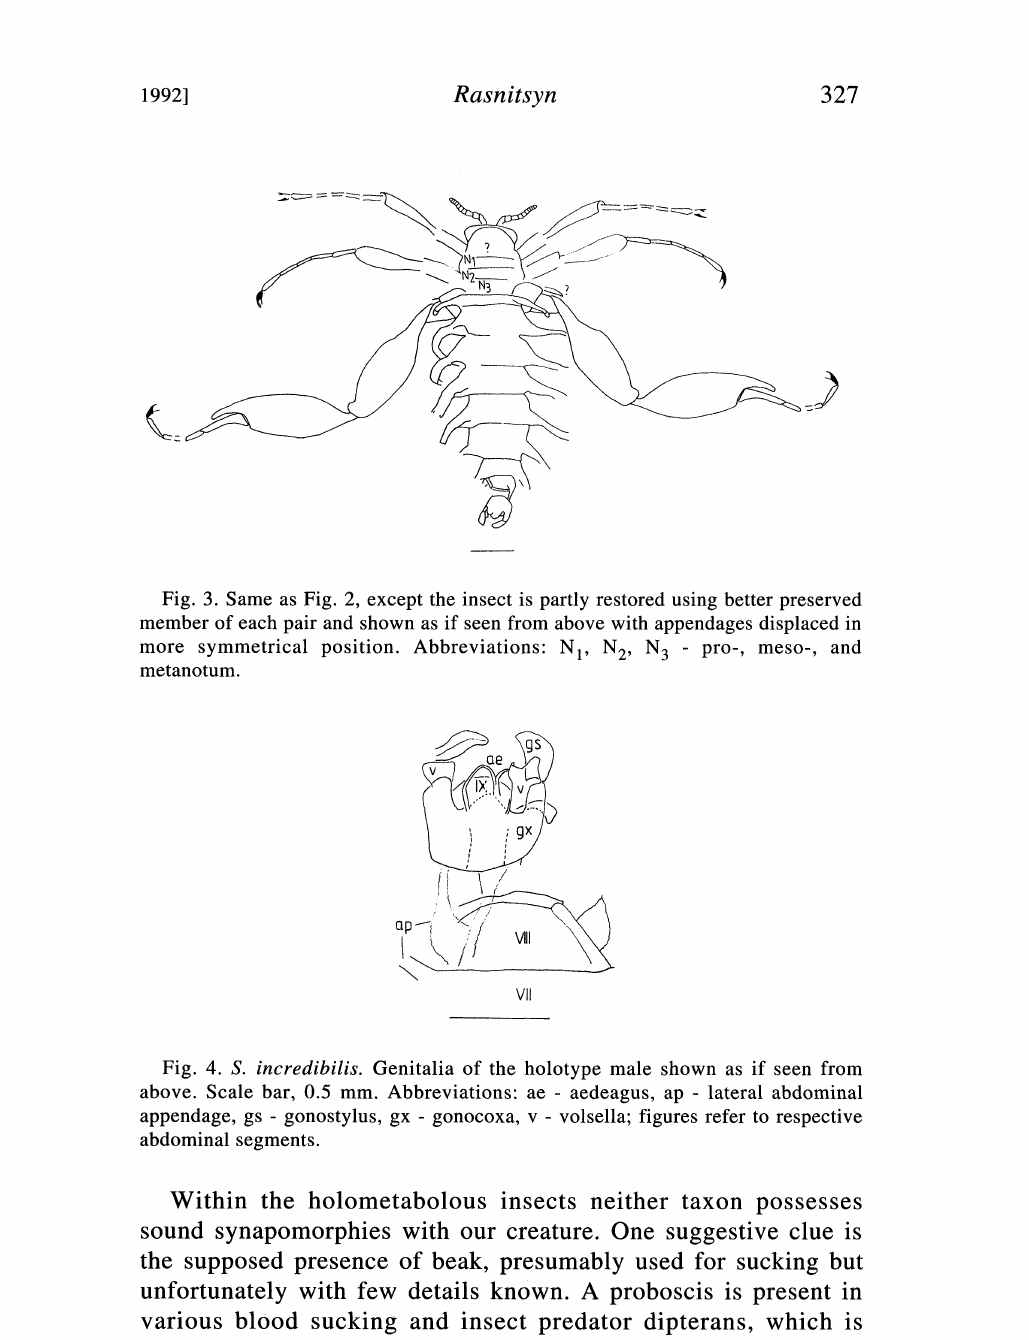
Fig. 4. S. incredibilis. Genitalia of the holotype male shown as if seen from above. Scale bar, 0.5 mm. Abbreviations: ae aedeagus, ap lateral abdominal appendage, gs gonostylus, gx gonocoxa, v volsella; figures refer to respective abdominal